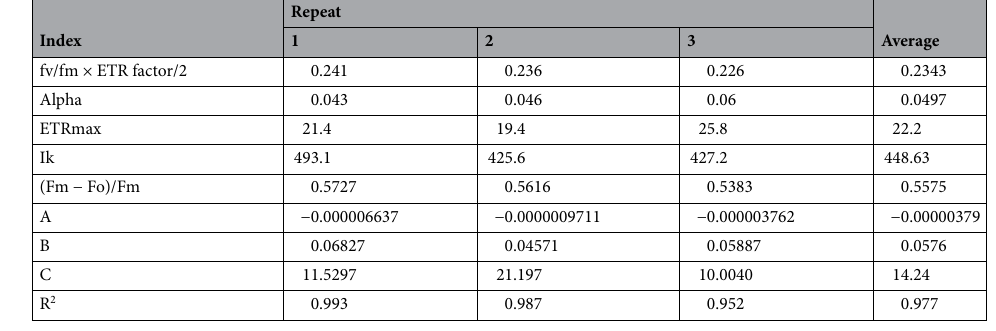
Table 6. Results of fitting rapid light curves of chlorophyll fluorescence in Epimedium pubescens leaves. fv/fm × ETR factor/2 is the maximum quantum yield of photosynthetic system II with a saturated pulse after dark adaptation. Alpha is the initial slope. ETRmax is the maximum electron transport rate. Ik is the minimum saturation of the light intensity.